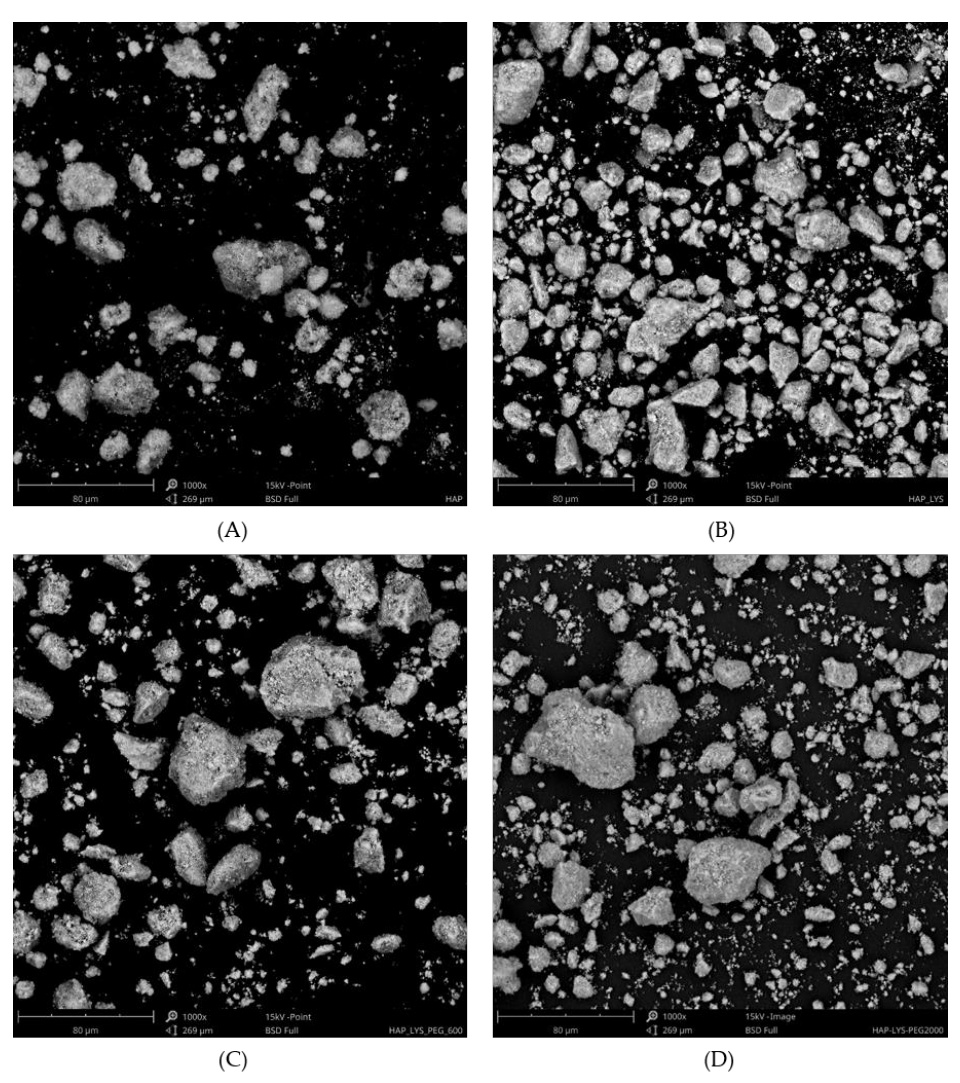
Figure 3. SEM images of ( A ) HAP, ( B ) HAP-Lys, ( C ) HAP-Lys/PEG600, and ( D ) HAP-Lys/PEG2100. Table 1. Elemental Composition and Average Particle Size (Presented as Average and Standard Deviation) of Pure and Modified Hydroxyapatite (HAP) Samples.